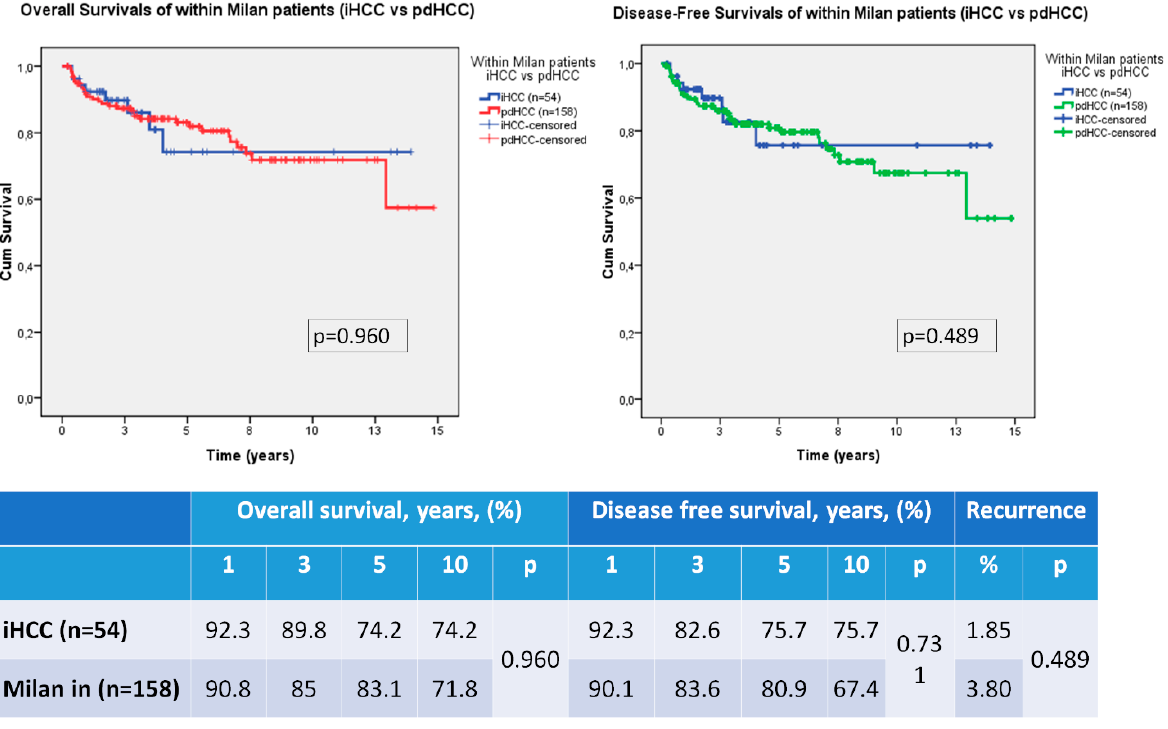
Figure 2. Survival comparison of Hepatocellular carcinoma patients (iHCC vs. within Milan in pdHCC).